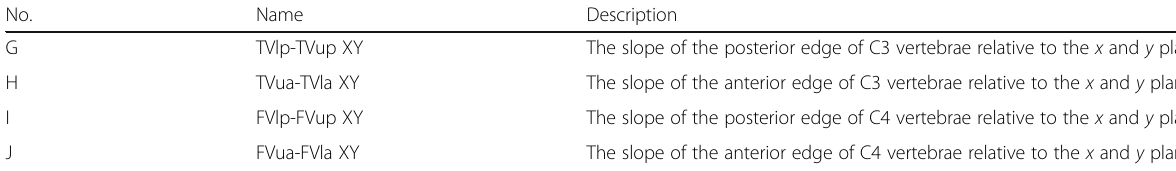
Table 3 The anterior and posterior vertebral slope measurements No.